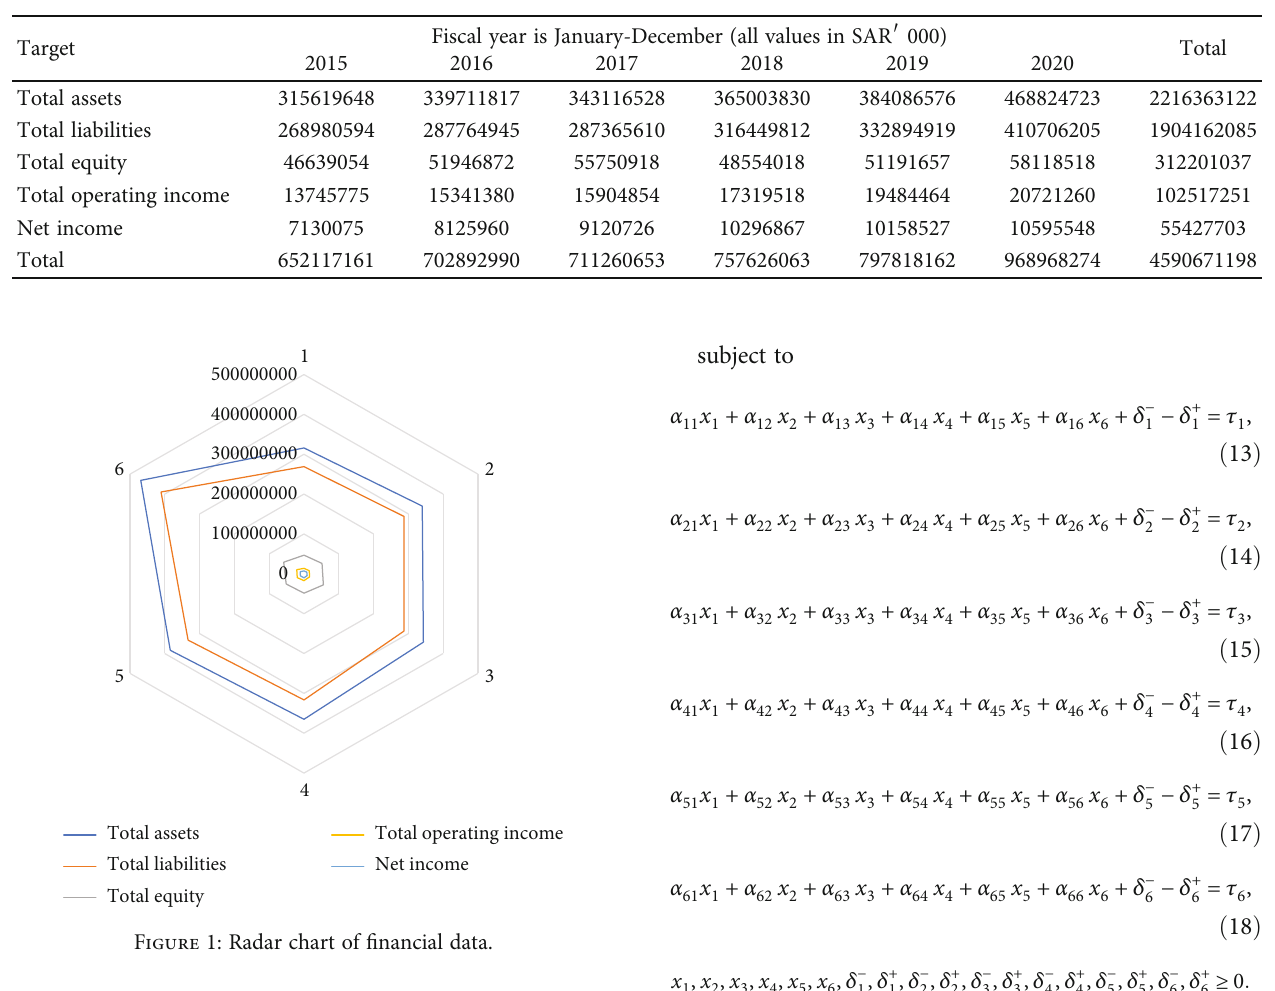
Table 2: Financial data from the Al Rajhi Bank.